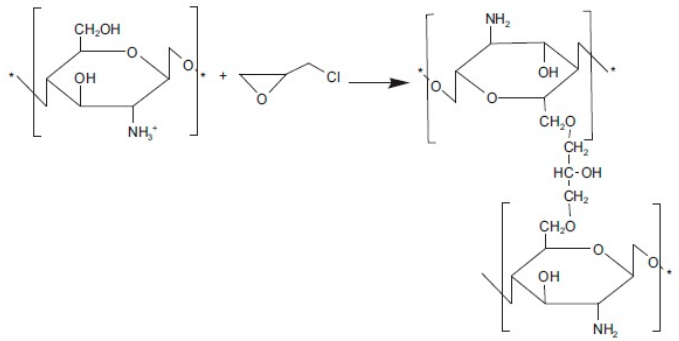
Figure 15. Structure of CS cross-linked with glutaraldehyde (GA) through Schiff’s base reaction [186]. Copyright 2010, reproduced with permission from Elsevier